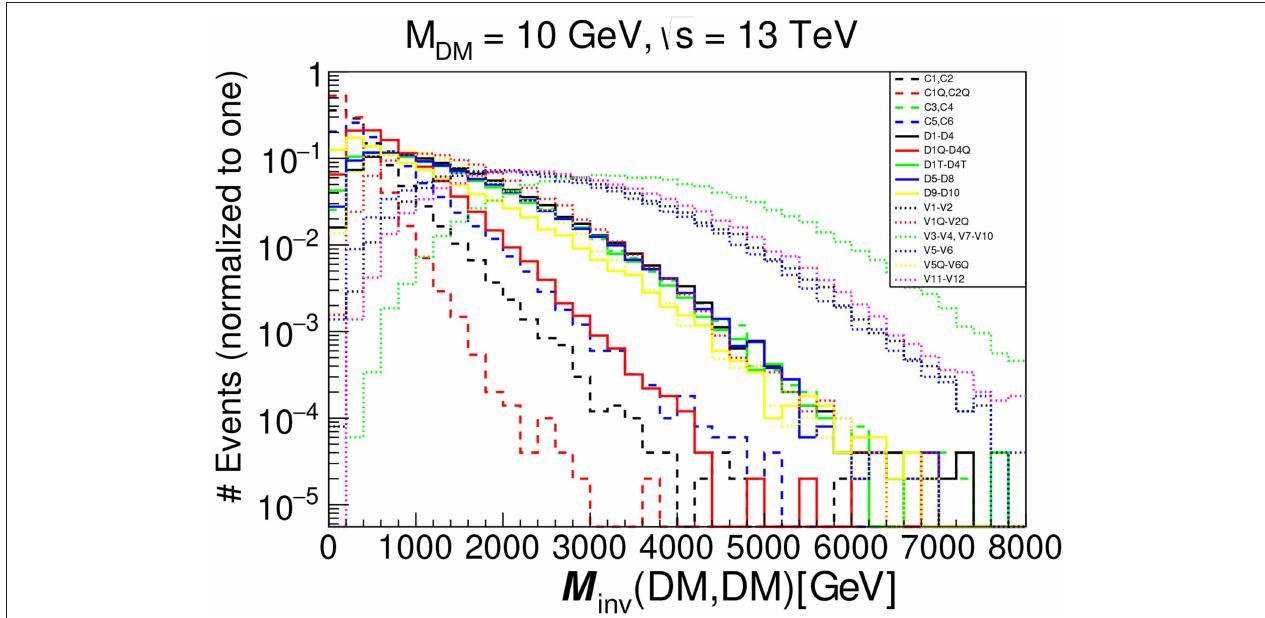
10 GeV and p T , jet 100 GeV cut = ≥